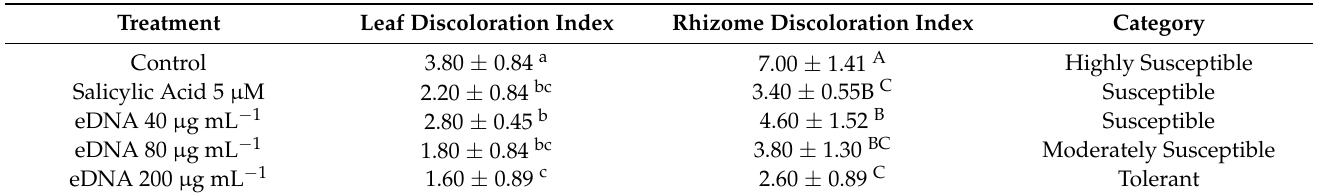
Figure 2. Effect of eDNA application from Foc TR4 on the resistance of banana plantlets cv. Cavendish to Foc TR4 infection, determined by examining the morphology and relative expression of pathogenesis- related 1 ( PR 1 ) and chitinase 1 genes. ( A ) Leaf and rhizome morphology of banana plantlet on day 8 after Foc TR4 infection. The observed symptoms of Foc TR 4 infection include leaves turning yellow and discolored rhizomes. ( B ) Relative expression of PR 1 and chitinase 1 genes compared with the GAPDH on day 9 post-infection. The asterisk represents a significantly different value based on independent t -test, while the black dots represent outlier data in each sampling point. Table 2. The effect of eDNA application to the dynamic of susceptible–resistant category based on leaf and rhizome discoloration indices